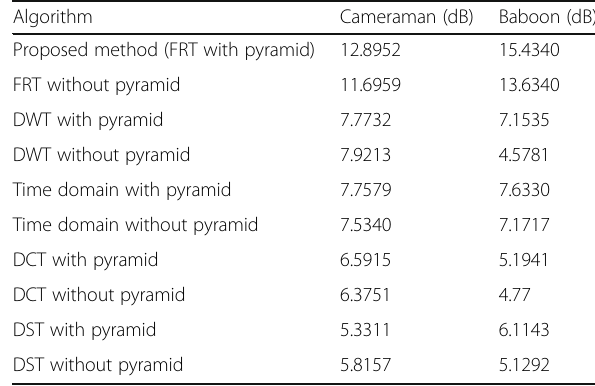
Table 1 SNR of overall separation performances on image mixtures